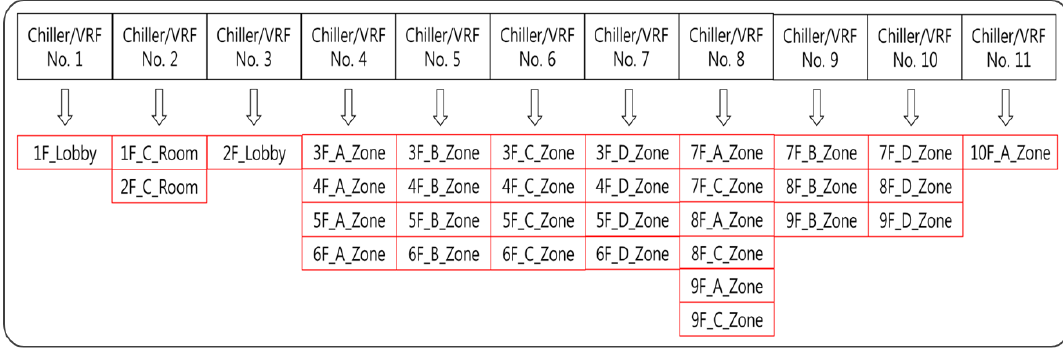
Figure 9. Configuration of VRF systems. Table 3. Reference capacity of each VRF system.